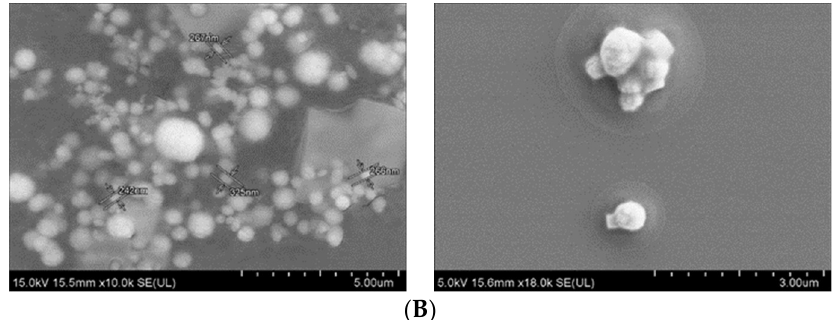
Figure 5. FE-SEM images of nanoparticles. ( A ). Micrographs of SSNs at 2 µ m and 500 nm scale, ( B ). Micrographs of Na-Glc-SSNs at 5 µ m and 3 µ m scale.